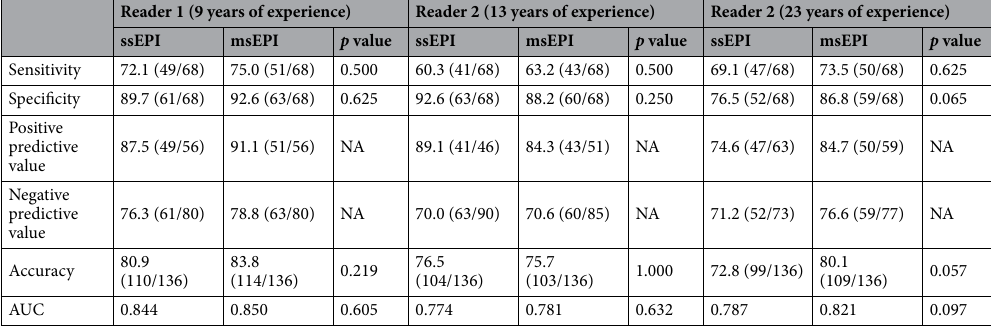
Table 5. Comparison of Diagnostic Performance for Clinically Significant Prostate Cancer Detection between ssEPI DWI and msEPI DWI. Data (excluding AUC) are presented as percentages, with values used to calculate percentages in